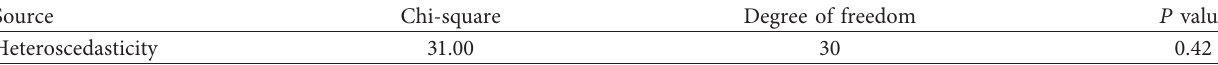
Figure 3: Descriptive statistics of crash severities and traffic violation types. (a) Proportions of crash severities. (b) Proportions of traffic-law violation types. Table 2: The result of White’s